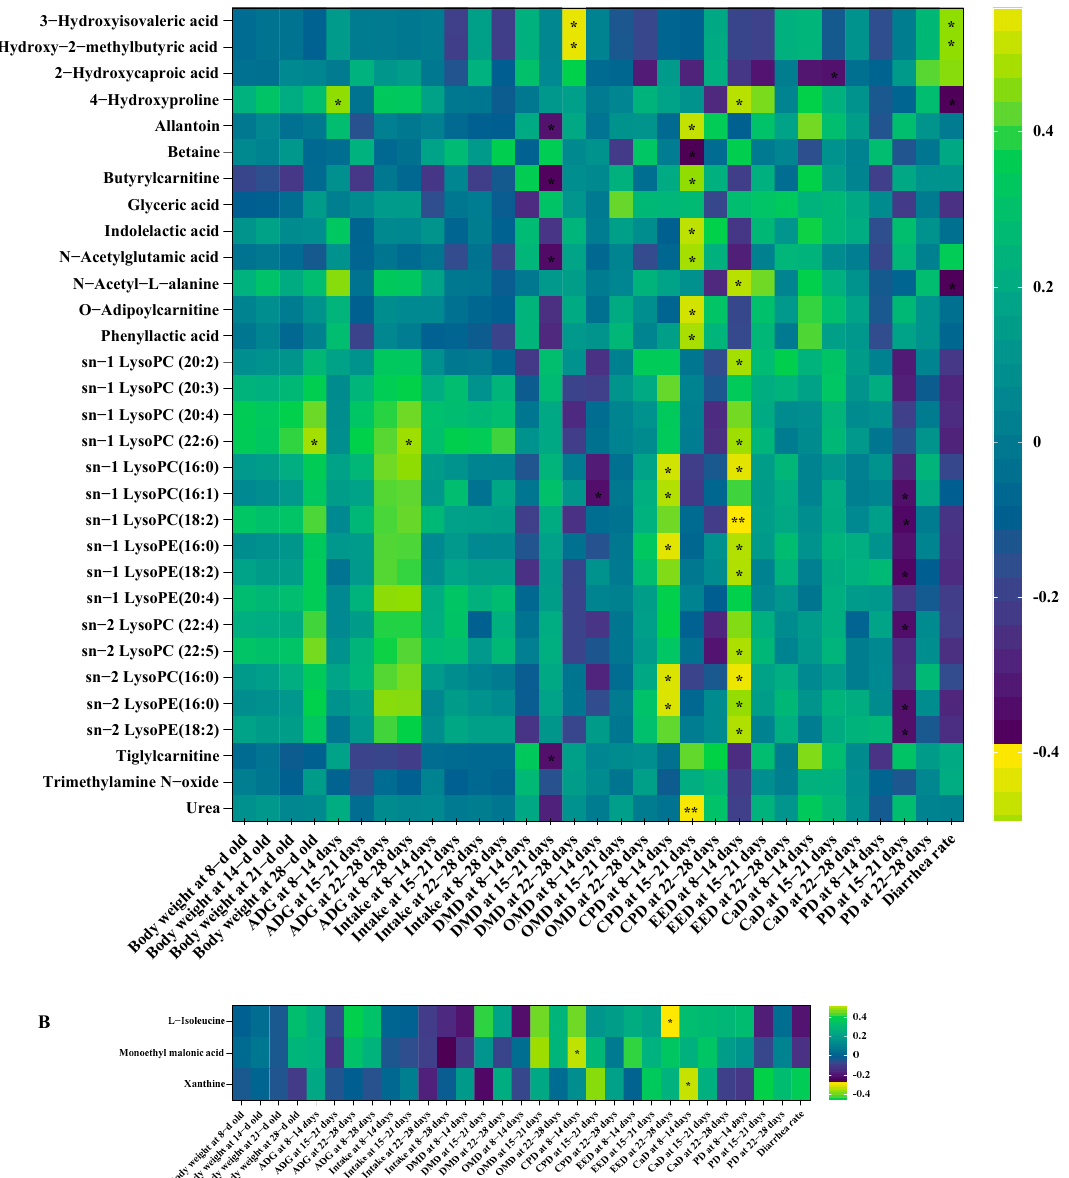
Figure 6. Correlation between serum ( A ) and urine ( B ) metabolites with growth performance of Hu lambs treated with either control or mannan oligosaccharides milk replacer. Lambs were fed milk replacers with or without 0.2% mannan oligosaccharides (MOS; n = 15 per treatment in growth per- formance measurement; n = 12 per treatment in metabolome analyses). The growth performances in 30 lambs and the serum and urine metabolites in 24 lambs divided into two groups based on MOS supplementation are shown for the 3–week collection phase of the study. ADG: Average daily weight gain; DMD: Dry matter apparent digestibility; OMD: Organic matter apparent digestibility; CPD: Crude protein apparent digestibility; EED: Ether extract apparent digestibility; CaD: Calcium apparent digestibility; PD: Phosphorus apparent digestibility. * Values within cells differ signifi- cantly at p ≤ 0.05, and ** values within cells differ significantly at p ≤ 0.01.